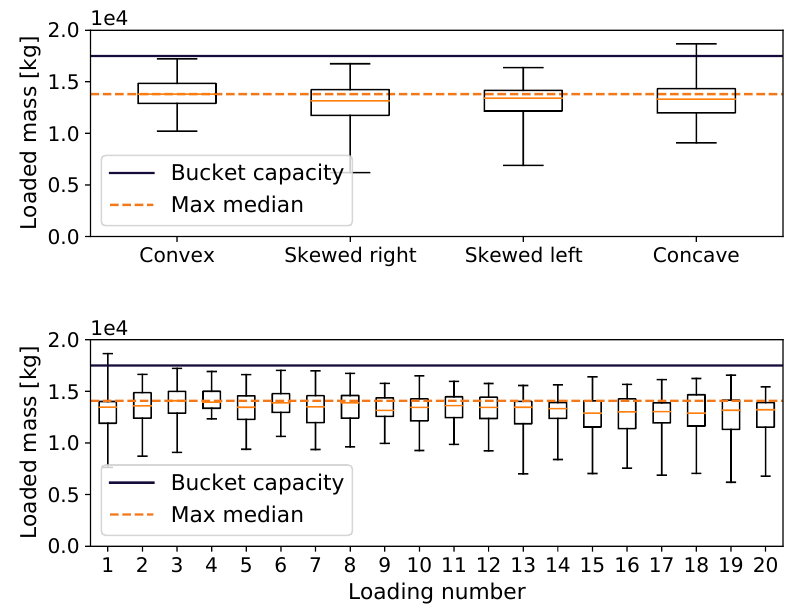
Figure 6. The distribution of mucking positions in the tunnel selected by the MPA for each of the four initial piles.